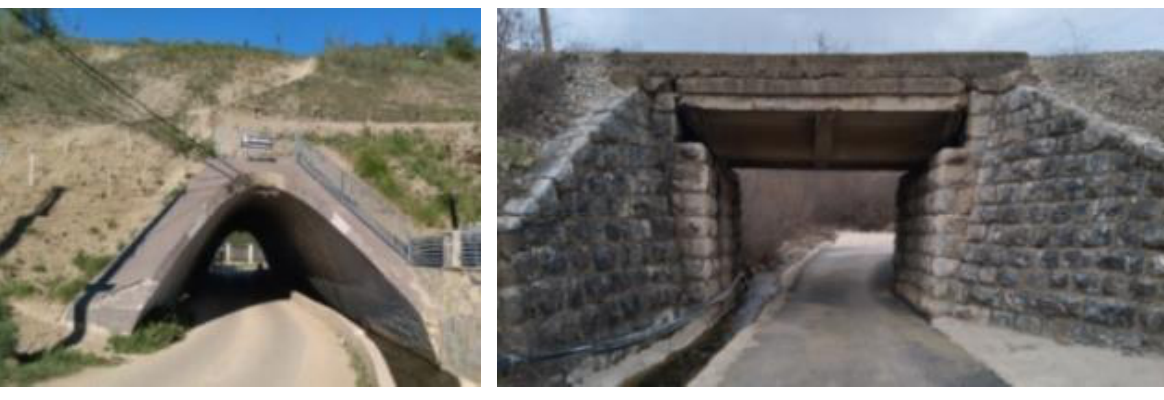
Figure 2. Types of bridges